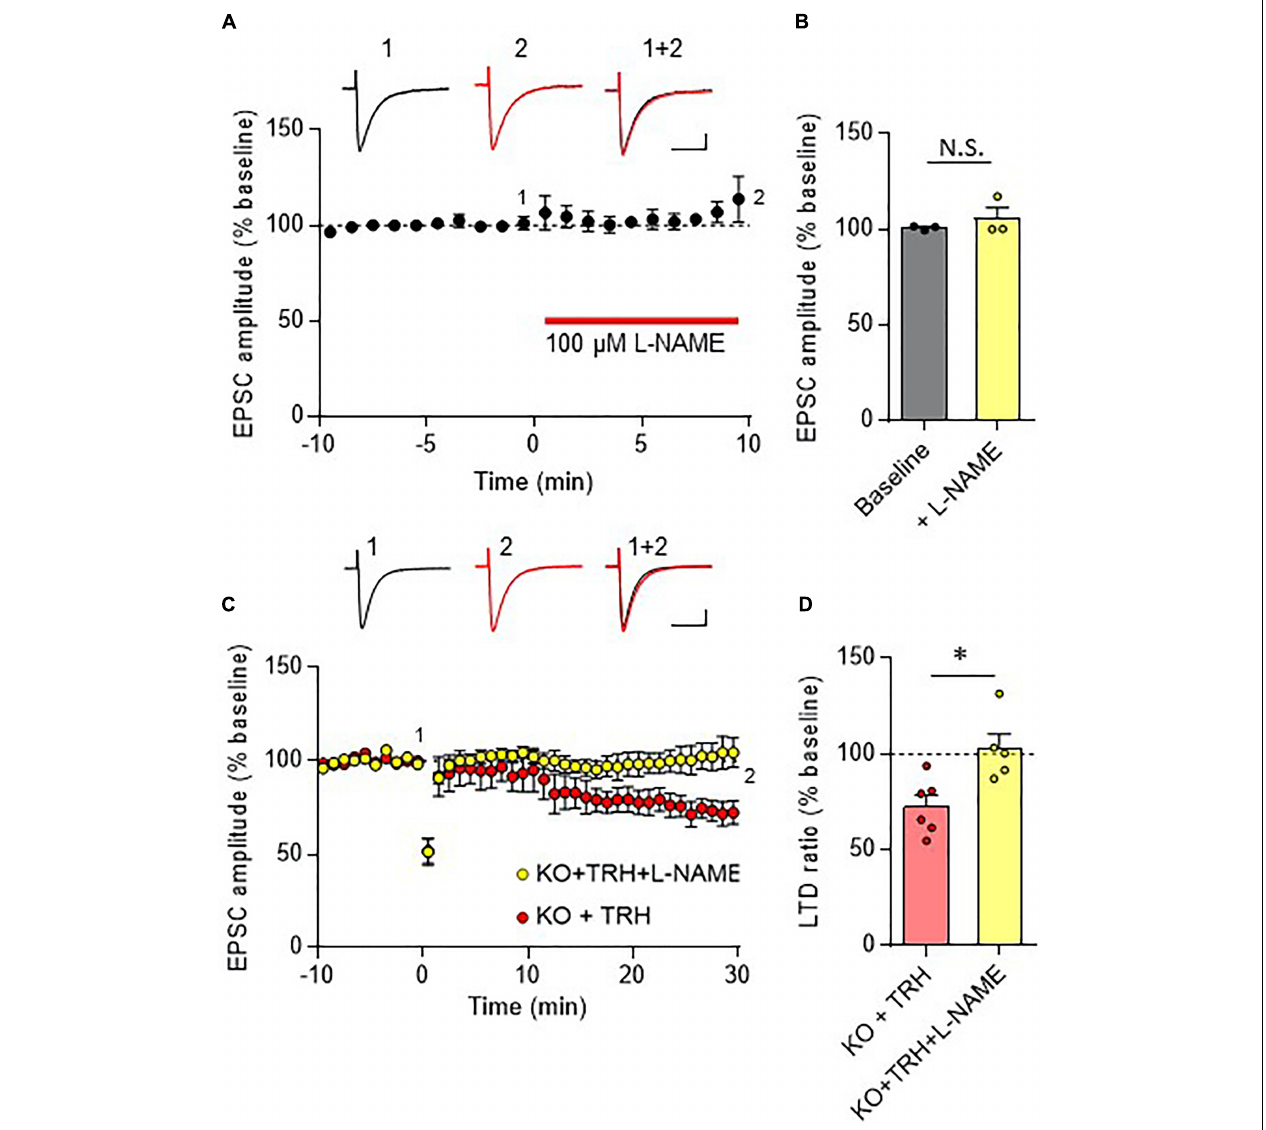
FIGURE 6 | Inhibition of the NO synthase eliminates the TRH-mediated rescue of cerebellar LTD. (A) Bath application of L-NAME, a cell-permeable NO synthase inhibitor, had no influence on PF EPSC. Representative traces before (1) and 10 min after (2) the L-NAME treatment are shown as black and red lines, respectively. Superimposed images (1 + 2) are also shown. Scale bar: 100 pA, 50 ms. (B) Summary graph showing the effects of 8-bromo-cGMP on EPSCs, which were calculated by dividing the averaged EPSC amplitude values obtained from –5 to 0 min or 5 to 10 min by those obtained from –10 to 0 min. (C) TRH fails to induce LTD in PCs from KO mice in the presence of 100 µ M L-NAME. Representative traces before (1) and 30 min after (2) the conjunctive stimulation is shown as black and red lines, respectively. Superimposed images (1 + 2) are also shown. Scale bar: 100 pA, 50 ms. (D) Summary graph showing depression ratios, which were calculated by dividing the averaged EPSC amplitude values obtained from 25 to 30 min by those obtained from –10 to 0 min (KO + TRH: six PCs from four mice, KO + TRH + L-NAME: five PCs from three mice). Data from KO mouse cerebellum treated only with TRH (KO + TRH) (C,D) , which are the same as those shown in the other figures, are presented for comparison. Asterisks indicate statistically significant differences, as determined using Welch’s t -test. ∗ P < 0.05. EPSC, excitatory postsynaptic current; KO, knock-out; L-NAME, N -nitro-L-arginine methyl ester; LTD, long-term depression; PF, parallel fiber.